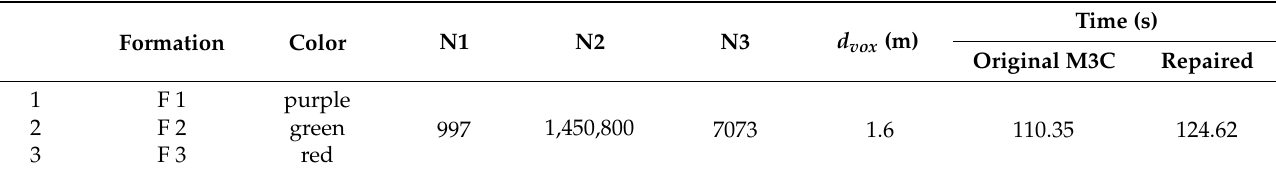
Table 2. The three-formation geological body statistics table. N1 is the number of the constraint points, N2 is the number of the voxel points of the models, N3 is the number of the voxel points that change their labels, and d vox is the voxel size. Formation